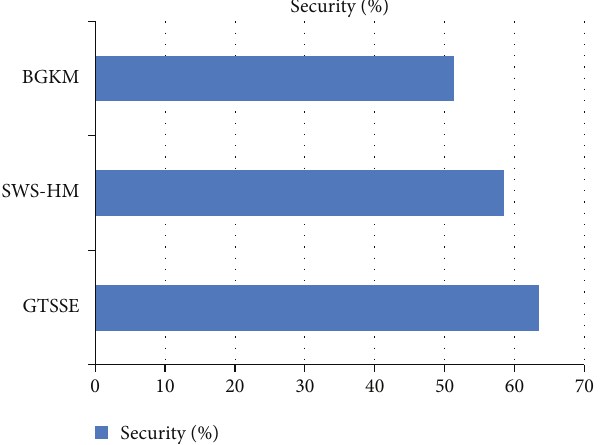
Figure 6: Security for three methods, GTSSE, SWS-HM, and